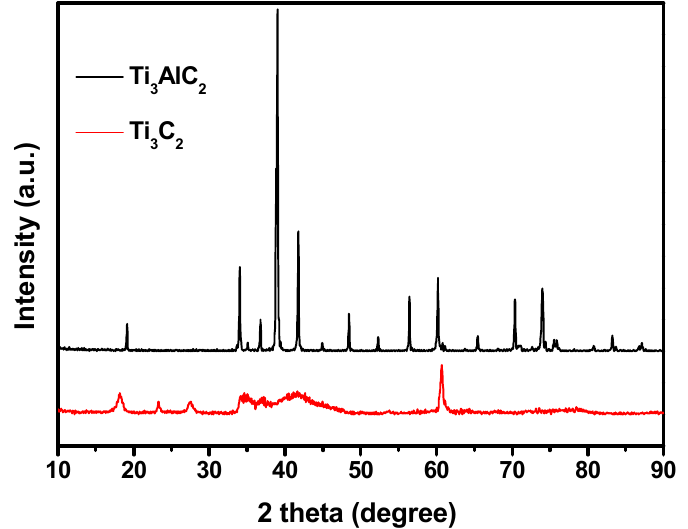
Figure 1. XRD patterns for Ti 3 AlC 2 and obtained Ti 3 C 2 by etching the Al layer of Ti 3 AlC 2 with HF solution.